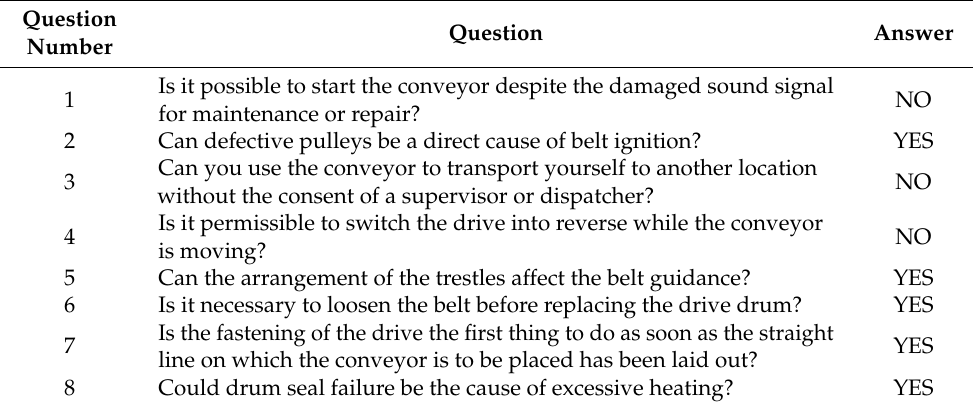
Table 1. Questions from the selected training day with correct